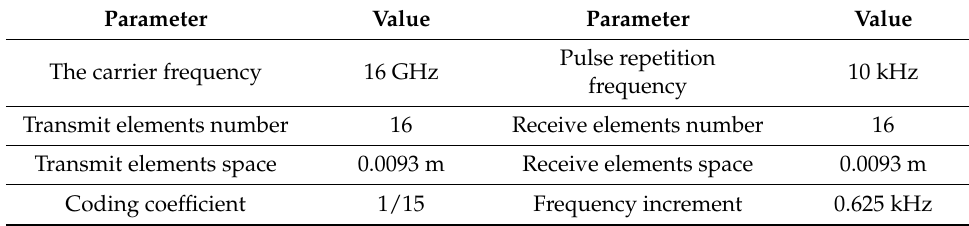
Table 1. Parameters of QPC-FDA-MIMO system.